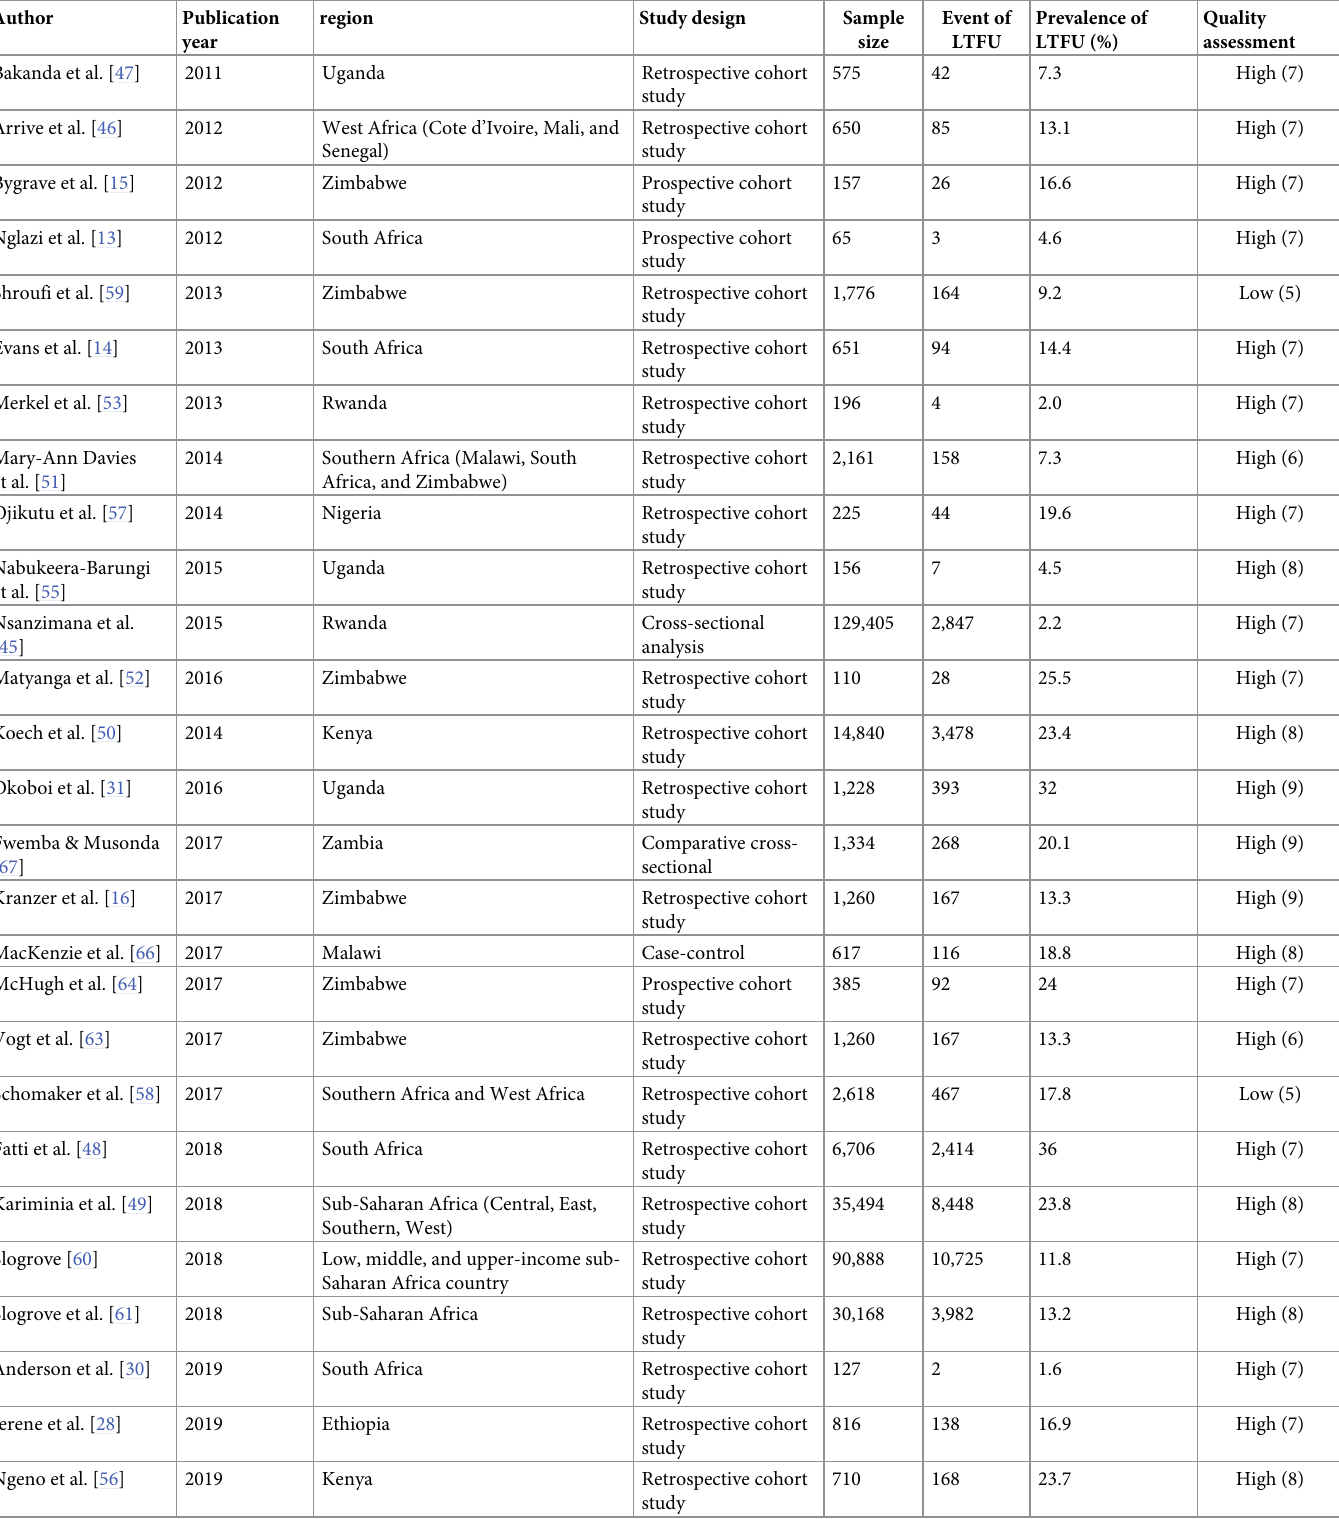
Table 1. Descriptive summary of 29 studies included in the meta-analysis of LTFU among HIV-positive adolescents (10–19 years old) on ART in